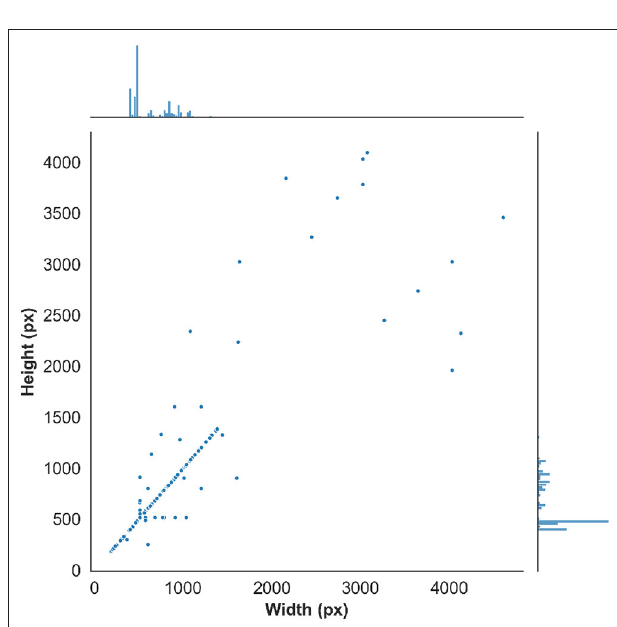
FIGURE 4 | Distribution of the image width and image height in the public dataset.